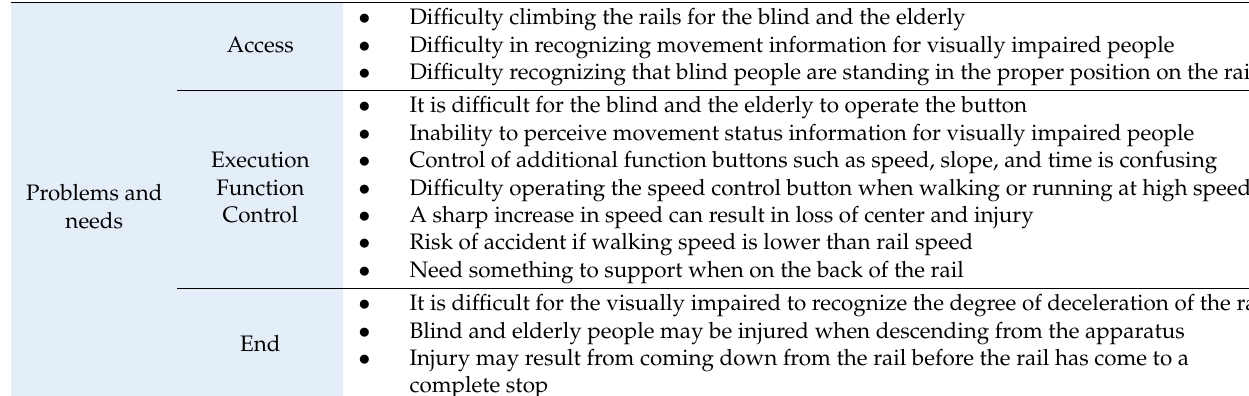
Table 7. Problems of existing treadmills and concept ideas applying universal design.